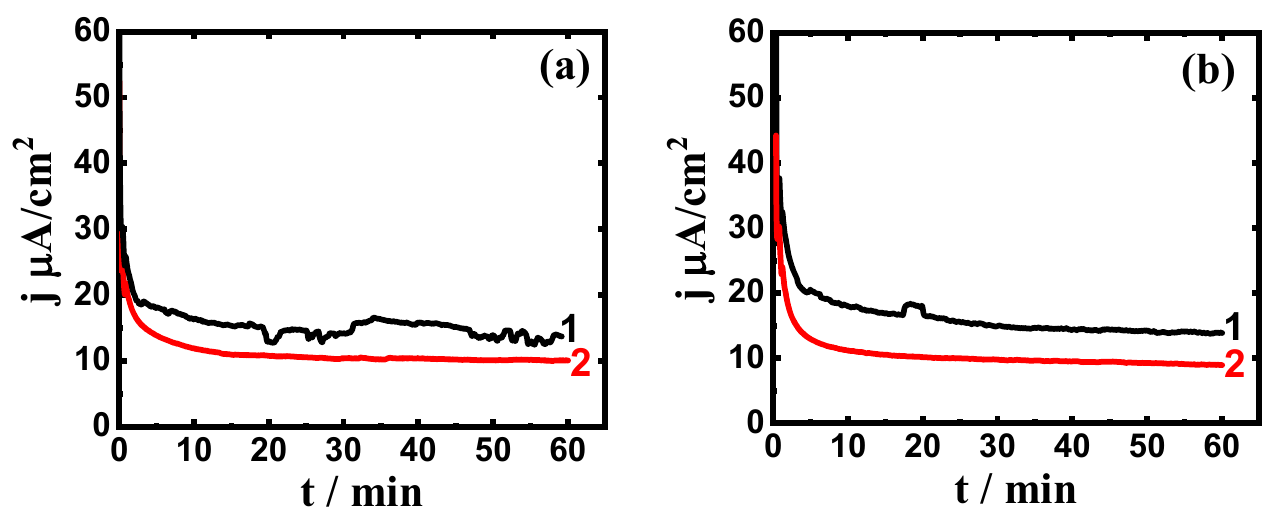
Figure 9. PCT curves at 400 mV (Ag/AgCl) for (1) Ti and (2) Ti85-Zr15 after ( a ) 1 h and ( b ) 72 h exposure to SBF, respectively.